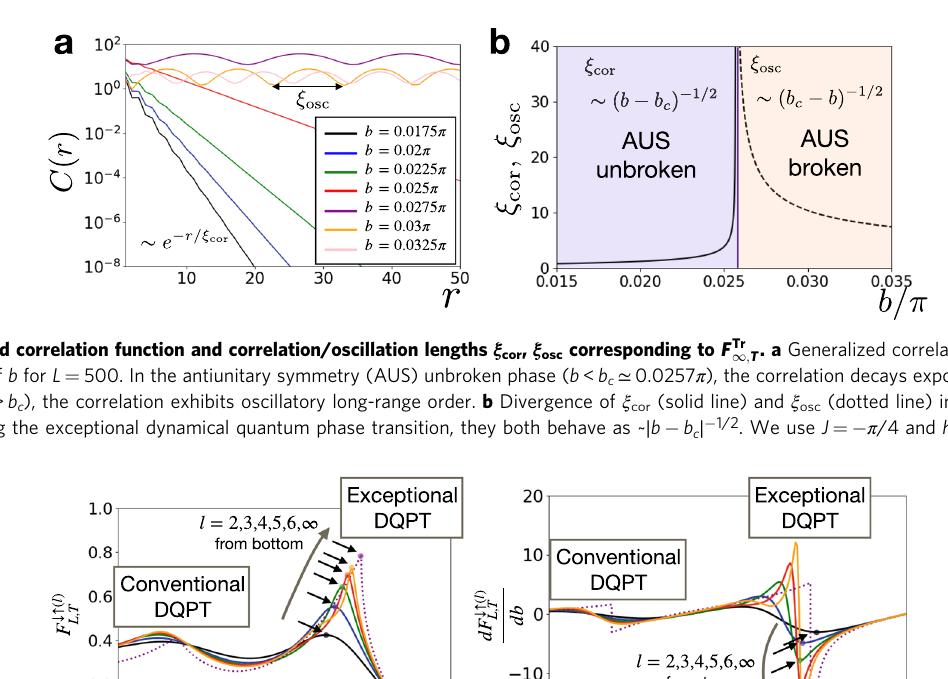
Fig. 5 The signature of the exceptional dynamical quantum phase transition (DQPT) using quasi-local observables. We show F #"ð l Þ L ; T and its derivative, which are described by the expectation value of quasi-local observables. We fi nd that the peaks (indicated by the dots and arrows) develop even for small l around the exceptional DQPT ( b ≃ 0.44 π ). Particularly, the peaks for the derivative become rapidly sharper as increasing l , re fl ecting the divergence for l = L → ∞ . This is in contrast with the conventional DQPT ( b ≃ 0.33 π ), where we cannot fi nd sharp peaks for l ≤ 6. We use L = 100 for l = 2 (black), 3 (blue), 4 (green), 5 (red), 6 (orange) and L = ∞ for l = ∞ (purple dotted), T = 5, J = − 0.25 π and h =